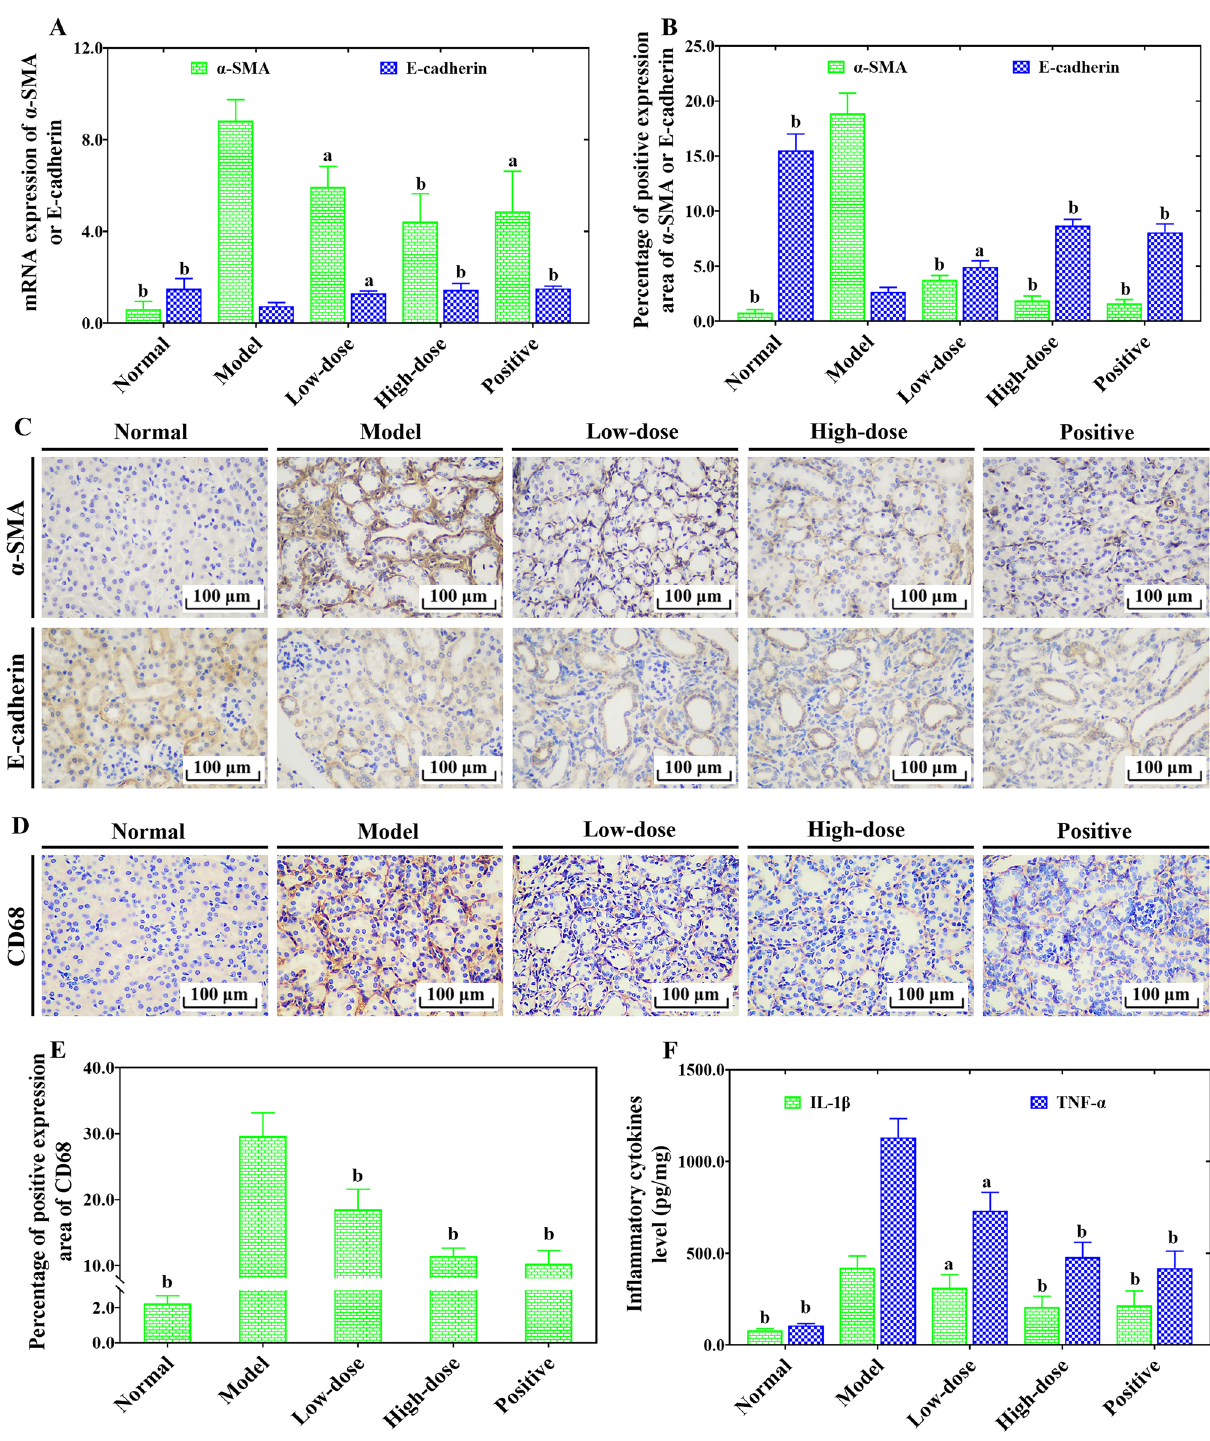
Figure 6. The effects of COS on α-SMA, E-cadherin and CD68 expression, and inflammatory cytokines secretion level of kidney tissues in UUO-induced renal fibrosis mice. The mRNA expression of α SMA and E-cadherin ( A ). Percentage from positive staining area of α-SMA and E-cadherin to the entire field of view ( B ). Representative immunohistochemical staining image of α-SMA and E-cadherin ( C ). Representative immunohistochemical staining image of CD68 ( D ). Percentage from positive staining area of CD68 to the entire field of view ( E ). Inflammatory cytokines secretion level of kidney tissues ( F ). All values are represented as mean ± SD (n = 10 in each group). Superscript letters a and b designate significant differences. a P < 0.05 compared with the model group. b P < 0.01 compared with the model